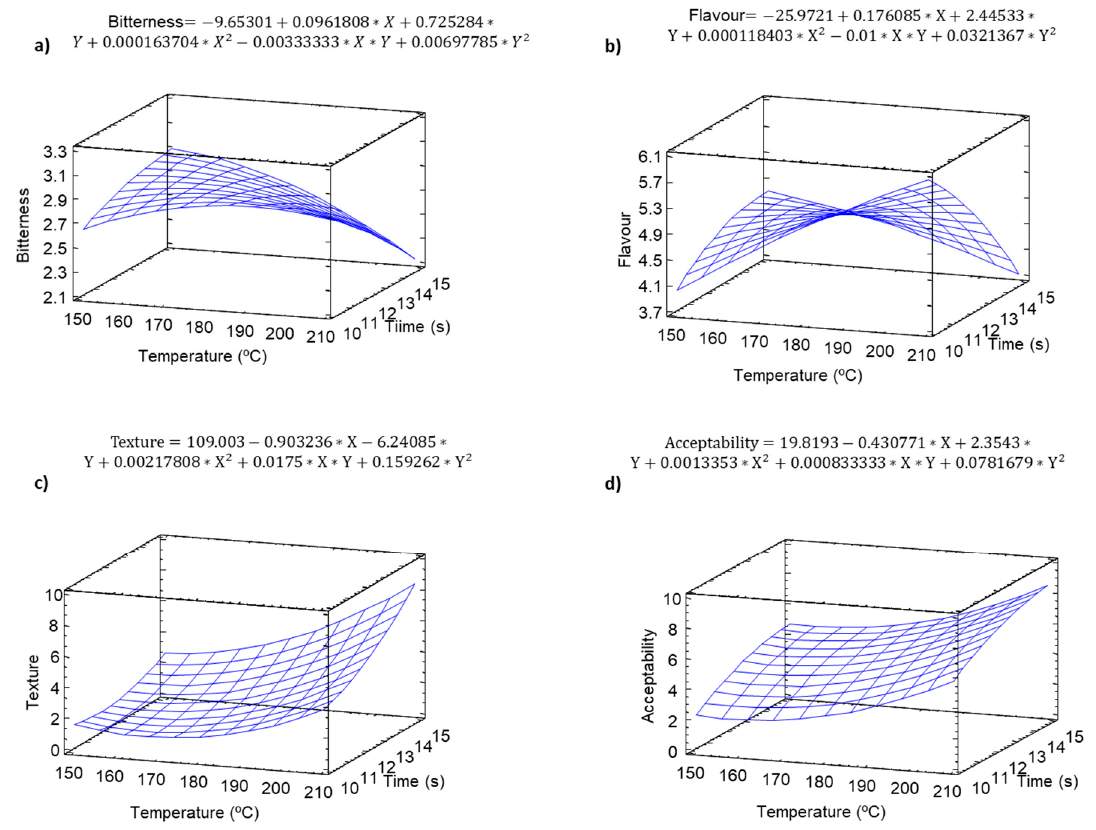
Figure 9. Sensory analysis of the snacks. Equations and modeled variations in the effect of temperature and time on ( a ) the bitterness, ( b ) flavor, ( c ) texture, ( d ) acceptability.